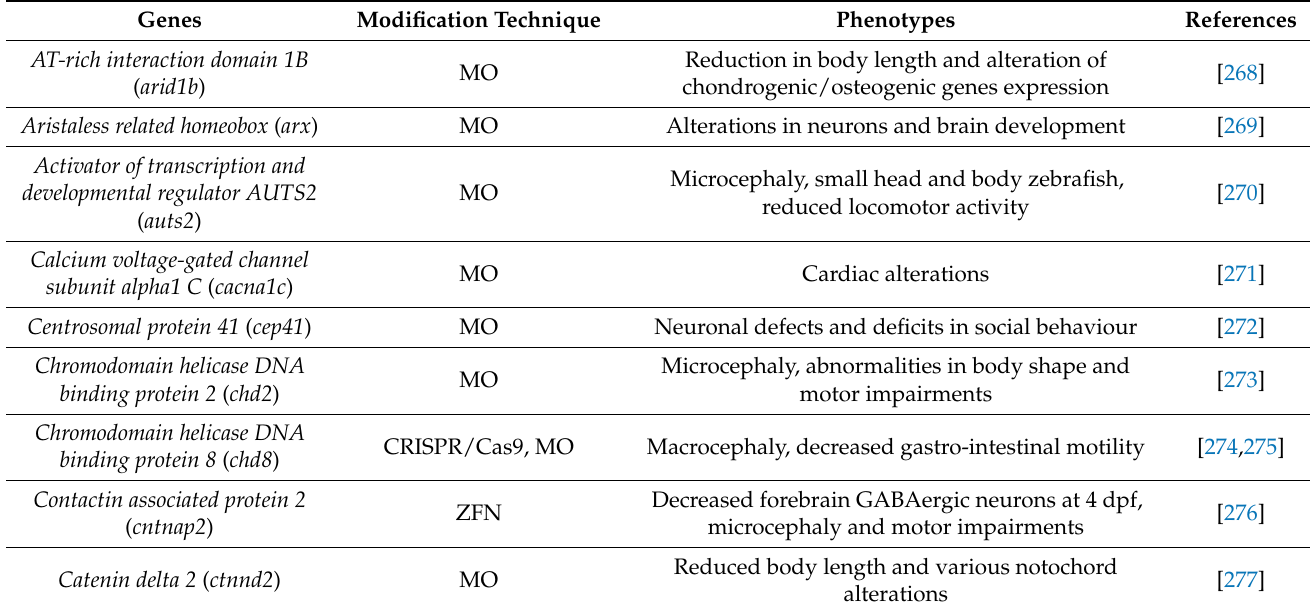
Table 8. Principal zebrafish ASD models and phenotypes observed. This table presents the main zebrafish models in the literature and the reported phenotypes. ENU: ethylnitrosourea; MO: mor- pholino, TALEN: transcription activator-like effector nucleases; ZFN: zinc-finger